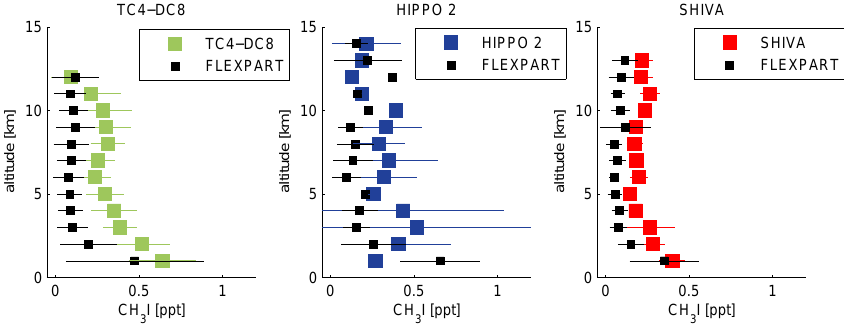
Fig. 7. Comparison between observed and modeled vertical profiles of CH 3 I in the troposphere and lower TTL. Observations from all tropical flight sections of each aircraft campaign are used to find coincident model output. Observations and model results are averaged over all coincident data points in 1km wide vertical intervals for TC4-DC8 (left panel), HIPPO2 (middle panel), and SHIVA (right panel). Horizontal bars indicate ± 1 standard